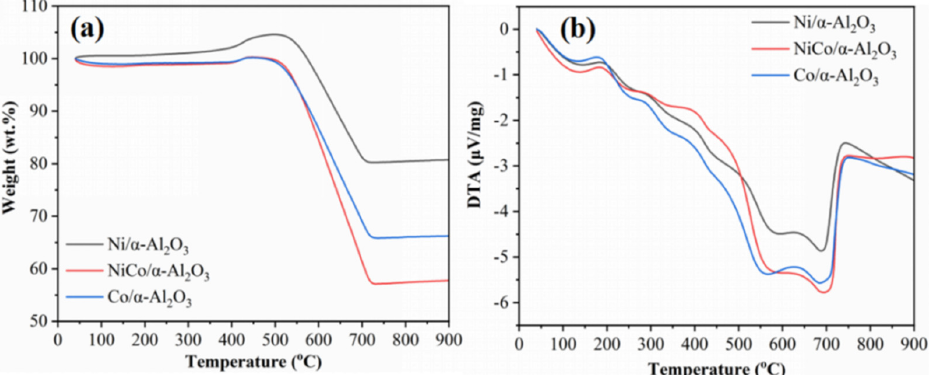
Figure 9. Temperature programmed oxidation ( a ) and DTA (exothermal in the negative direction) plots of CNCs produced with Ni/ α –Al 2 O 3 , NiCo/ α –Al 2 O 3 , and Co/ α –Al 2 O 3 catalysts ( b ).